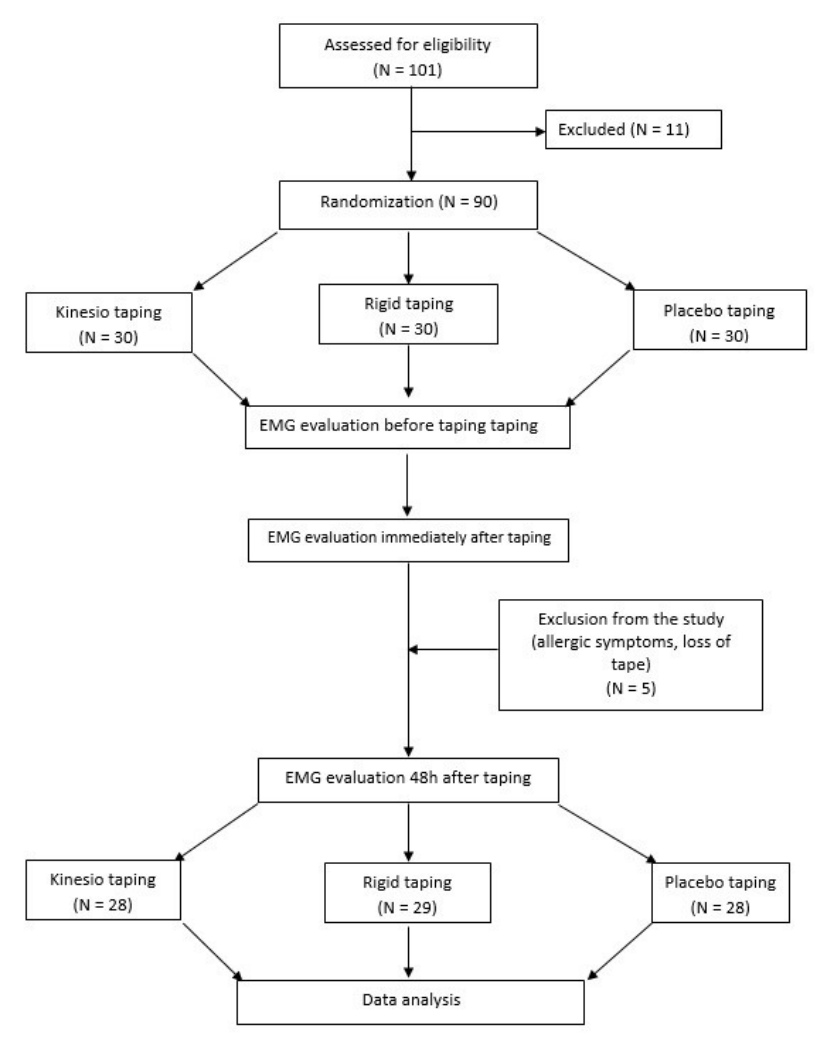
Figure 1. Flow Figure 1. Flow diagram.